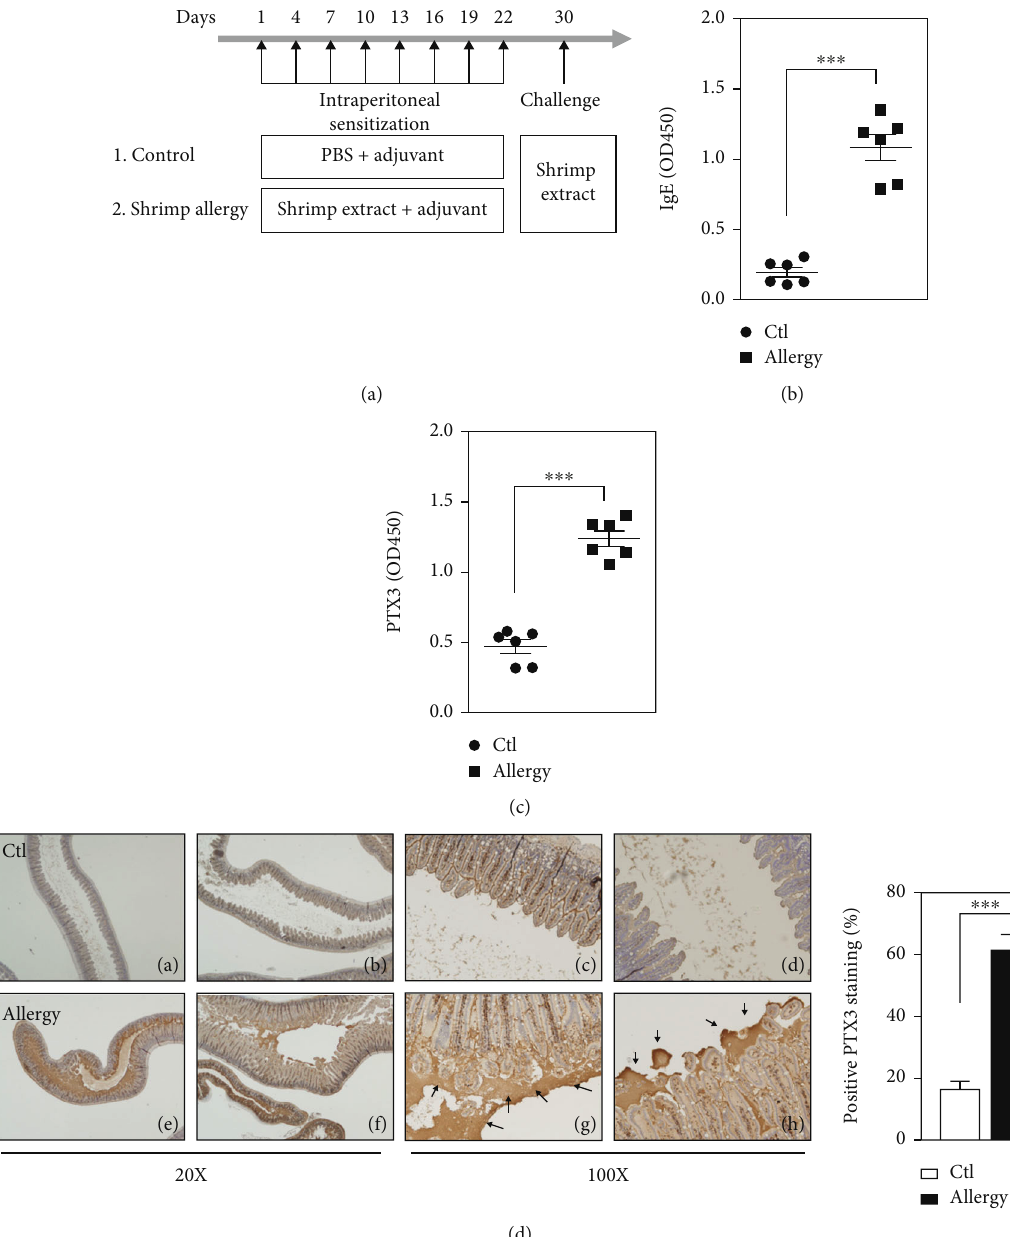
Figure 1: Levels of PTX3 are increased in the serum and small intestine of shrimp-allergic mice. (a) 3-4 weeks old female BALB/c mice ( n = 6 per group) were intraperitoneally sensitized and challenged with PBS or shrimp extract. Using Al(OH) as an adjuvant, shrimp 3 in PBS i.p. on days 1, 4, 7, 10, 13, 16, 19, and 22. Blood was collected after the allergy mice received shrimp extract plus Al(OH) 3 challenge on day 30 for the determination of IgE and PTX3 levels. (b, c) Levels of serological total IgE and PTX3 determined by ELISA. (d) Positive PTX3 immunoreactivity is shown from a representative small intestine of healthy control (a – d) and shrimp allergy (e – h) subjects (from 3 experiments, hematoxylin and PTX3 staining, and magni fi cations of 20 × and 100 × ). Arrows highlight the outer border of small intestinal villi with increased staining for PTX3. Brown staining indicates PTX3 expression. The quantitative analysis of positive PTX3 staining is shown in the